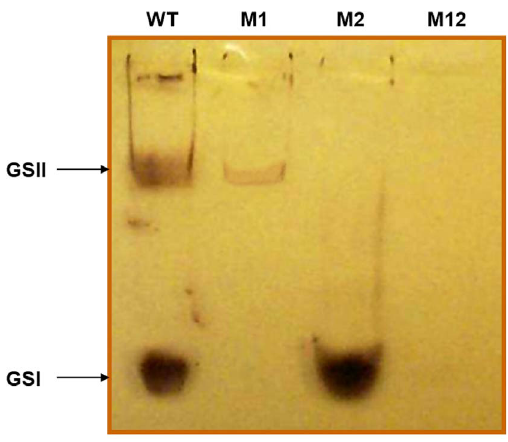
Figure 3 . Zymogram analysis of GS activity from wild-type and mutant cells. Ten m g of each soluble extract was subjected to native PAGE. The bands showing GS activity were visible after overnight incubation in a buffer containing ADP-glucose and rabbit-liver glycogen and were stained with iodine solution. Lane 1. WT, Lane2. M1 ( sll 1393 2 ), Lane3. M2 ( sll 0945 2 ), and Lane 4. M12 ( sll 1393 2 / sll 0945 2